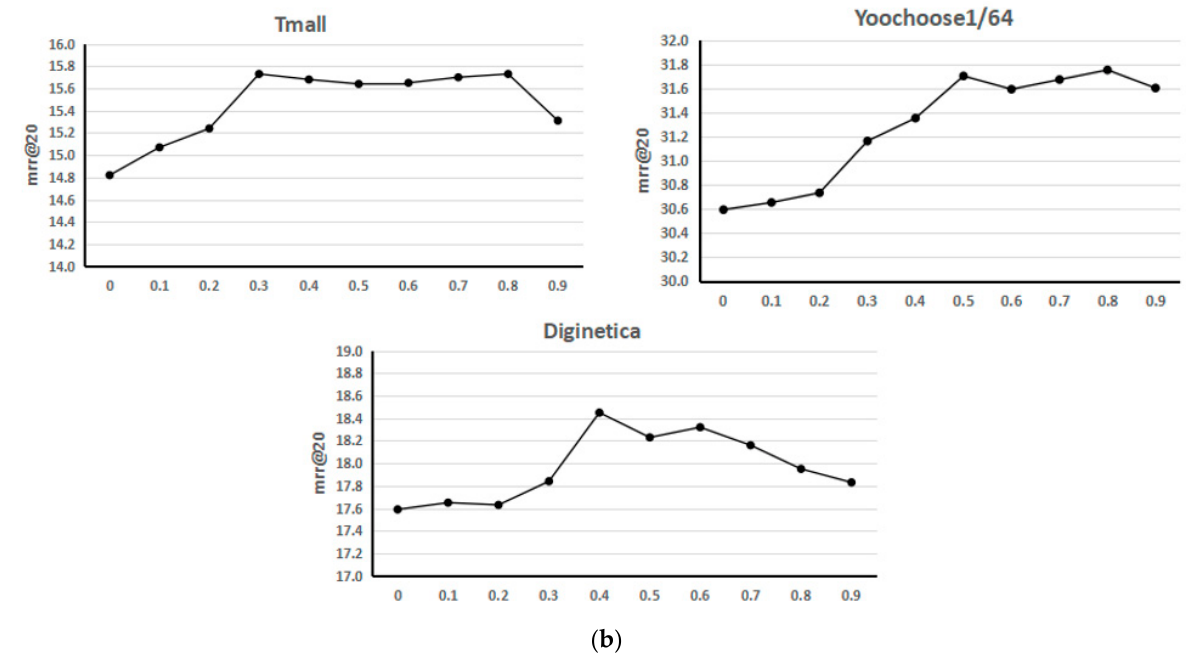
Figure 2. The effect of co-occurrence parameter 𝜙 (cid:3036)(cid:3037) in three. ( a )The effect of co-occurrence param- eter 𝜙 (cid:3036)(cid:3037) on P@20. ( b ) The effect of co-occurrence parameter 𝜙 (cid:3036)(cid:3037) on